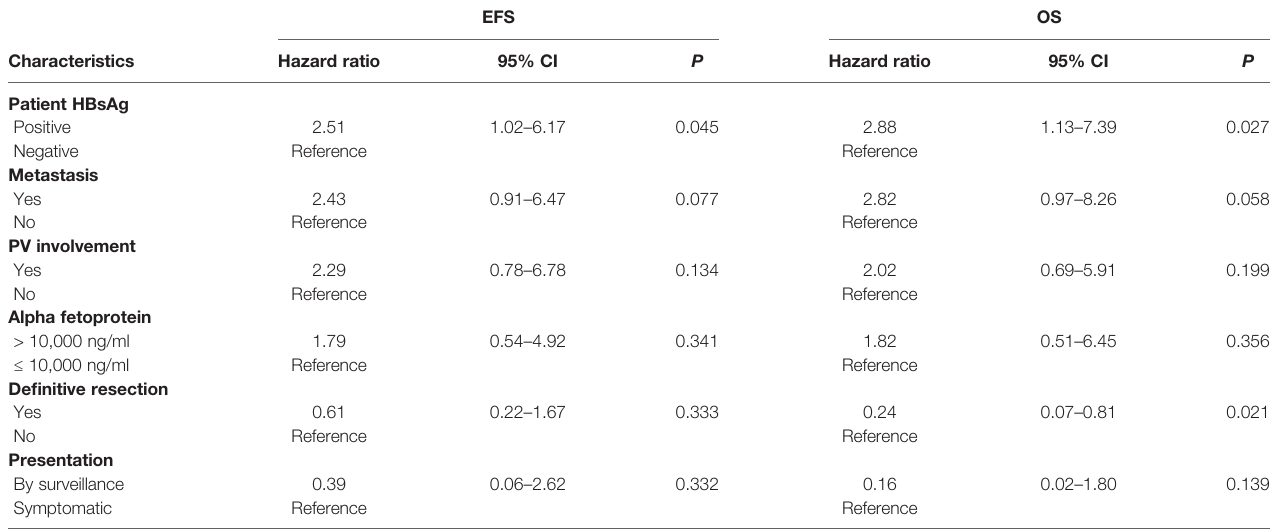
TABLE 3 | Multivariable Cox regression analysis on predictors for event-free survival (EFS) and overall survival